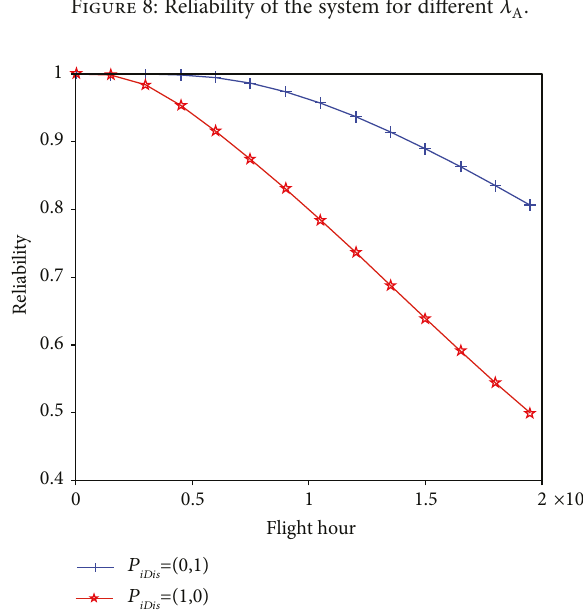
Figure 8: Reliability of the system for di ff erent λ